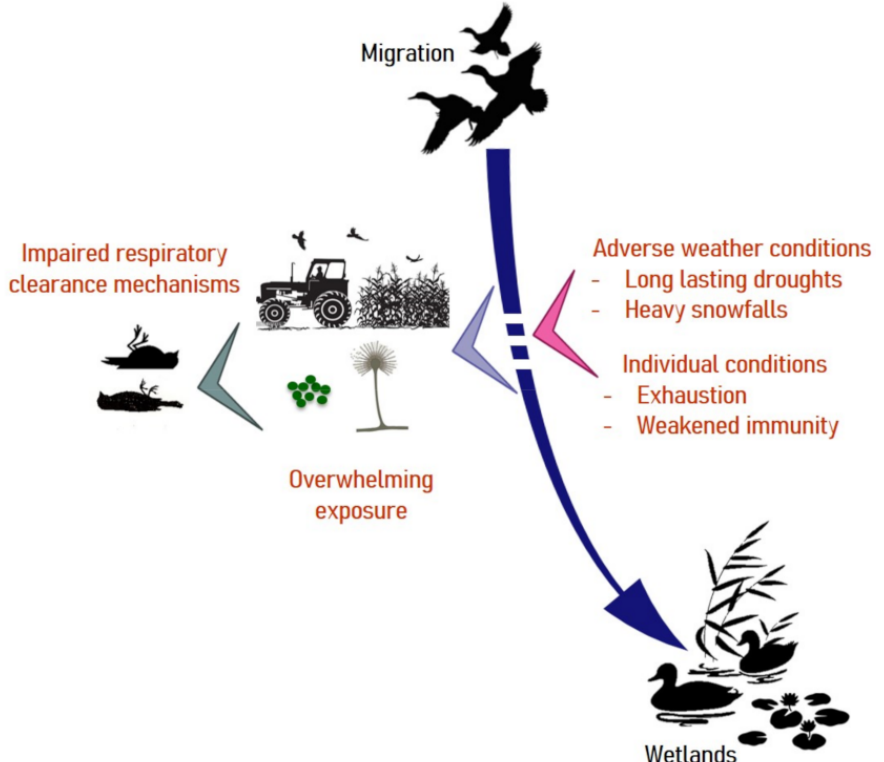
Figure 2. Risk factors associated with aspergillosis in migratory birds. Under usual climatic con- ditions, waterfowl exploit wetlands for food. Weather disturbances can force birds to take refuge on cultivated lands and feed on crop residues that are sometimes heavily contaminated by molds. Under such circumstances, exhausted individuals may suffer from airway clearance dysfunction and develop aspergillosis with a fatal